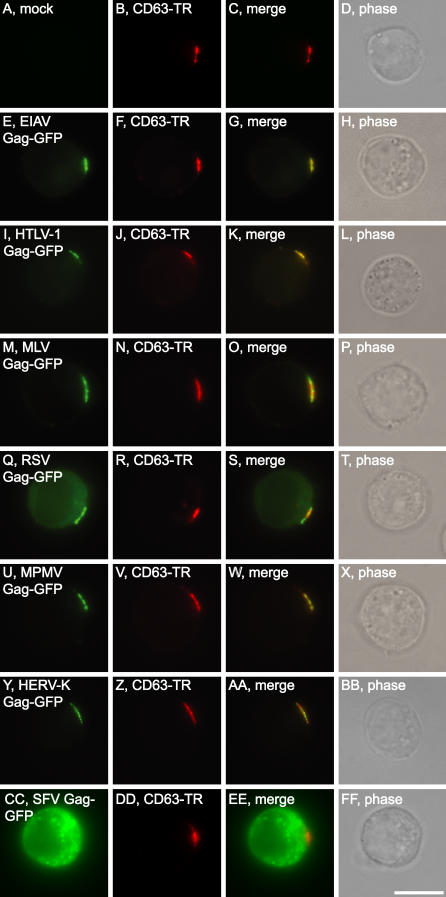
Jurkat T Cells Selectively Sort Orthoretroviral Gag Proteins to ELDsFluorescence microscopy of Jurkat T cells (A–D) untransfected (mock) and (E–FF) transfected with plasmids designed to express GFP-tagged Gag proteins from (E–H) EIAV, (I–L) HTLV-1, (M–P) MLV, (Q–T) RSV, (U–X) MPMV, (Y–BB) HERV-K, and (CC–FF) SFV, each stained for surface CD63. Bar indicates 10 μm.